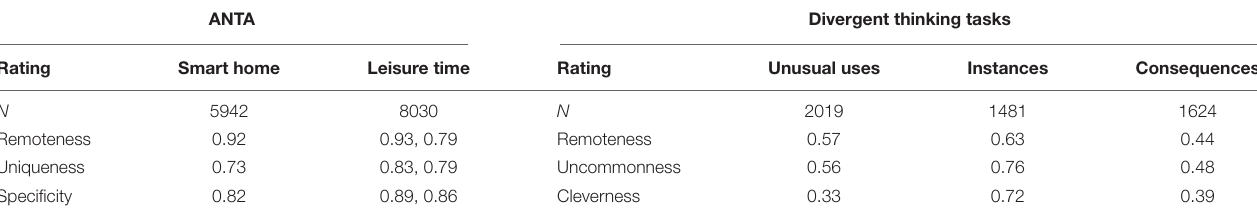
TABLE 4 | Interrater reliability table (Kendall’s